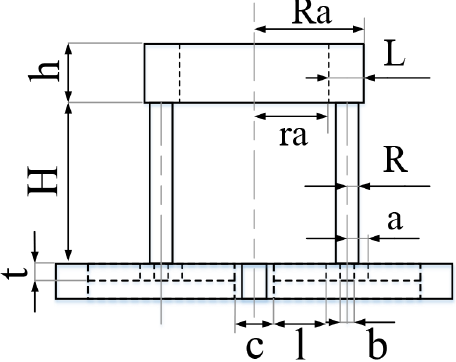
Fig. 5. Geometric parameter schematic of AFUVH.